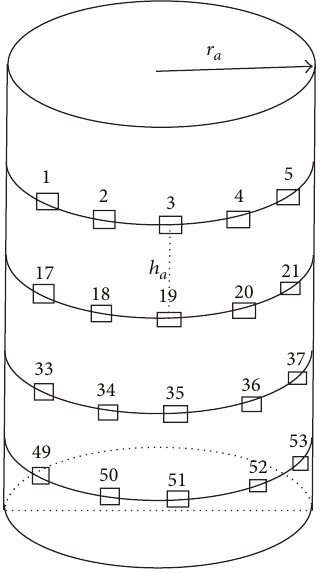
Figure 5: A cylindrical antenna